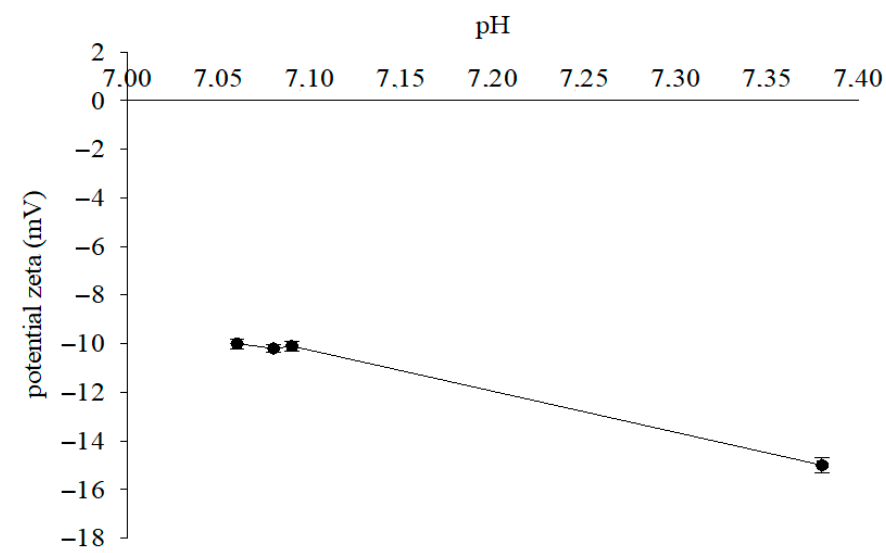
Figure 4. Nopalea cochenillifera biomass zeta potential as a pH function.